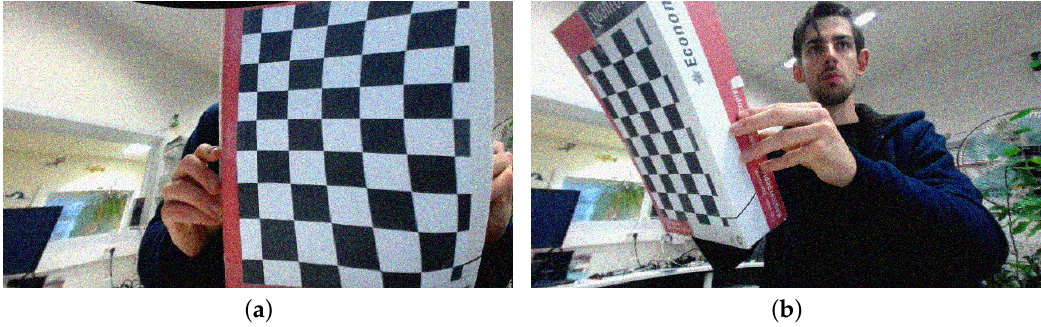
Figure 5. Two examples from the full training data set. These are the corresponding images from Figure 4 with added distortion and noise as discussed in Section